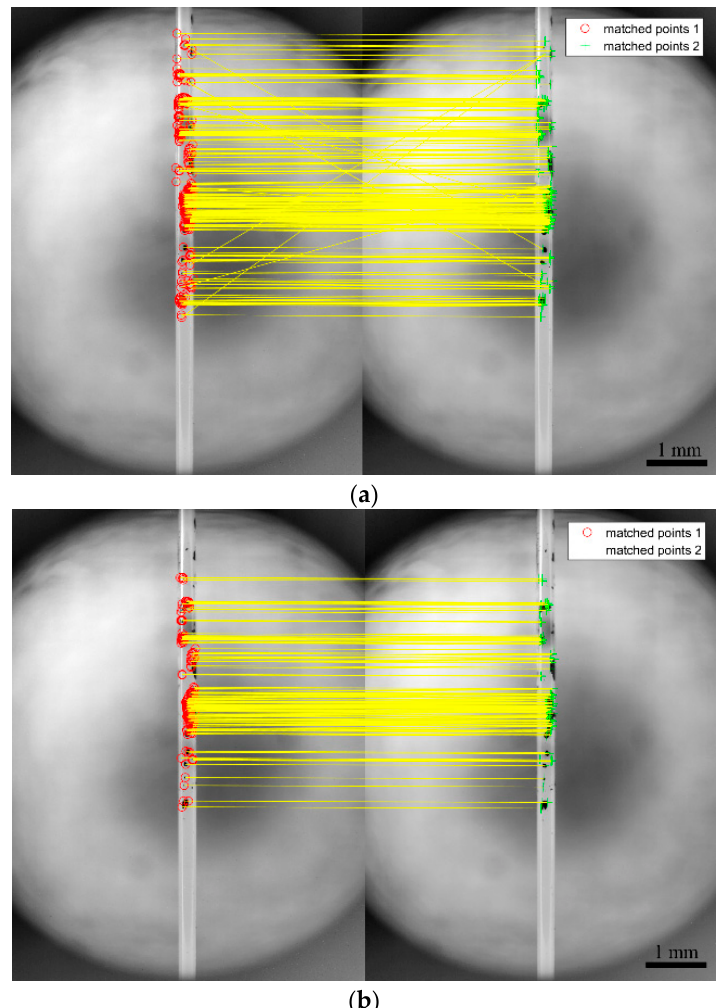
Figure 4. Matched points obtained using ( a ) speeded-up robust feature (SURF) only, and ( b ) SURF and M-estimator sample consensus (MSAC).